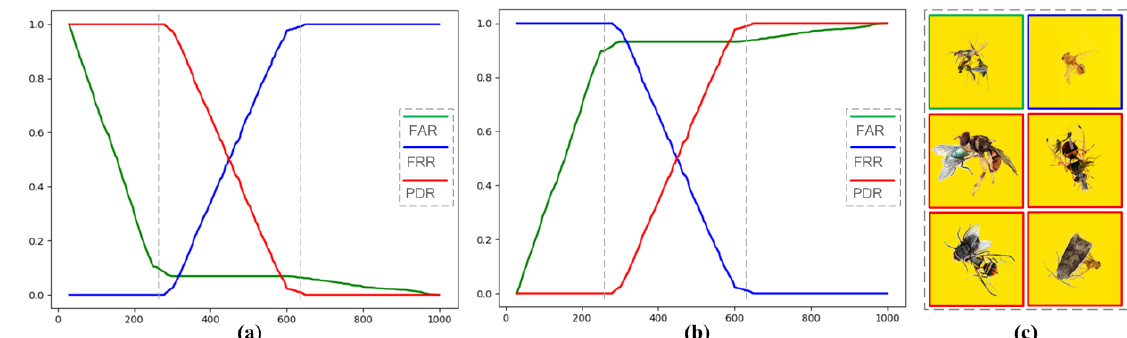
Figure 7. Analysis of the detection algorithm. ( a ) Effects of setting different τ l without considering τ u ; ( b ) effects of setting different τ u without considering τ l ; ( c ) error detections. The green-border image indicates a false acceptation. The blue and red-border images are the incorrectly rejected cases. Here, the FAR, FRR, and PDR respectively indicate the False Acceptation Rate, False Reject Rate, and Positive Detection